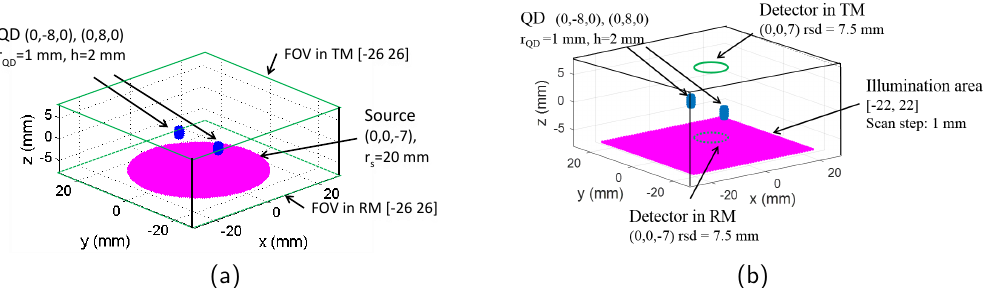
Figure 1. Simulation geometry of ( a ) full-field illumination system and ( b ) scanning system. FOV: field of view; TM: transmission mode; RM: reflection mode; QD: target containing quantum